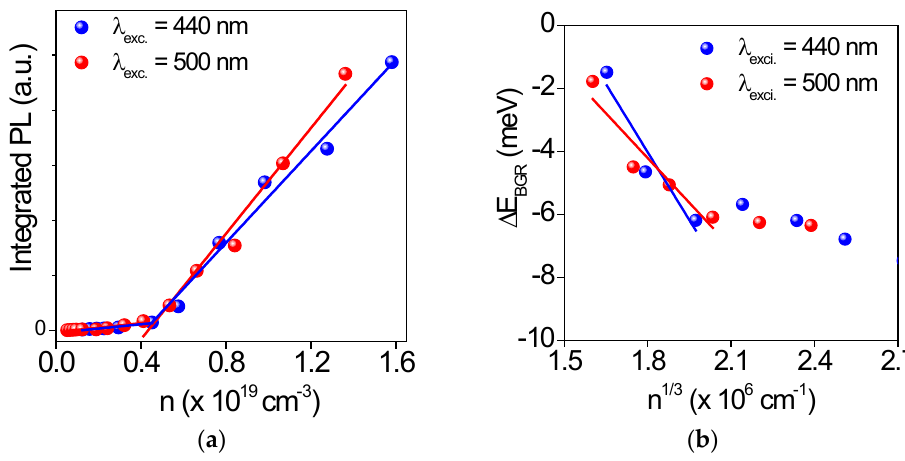
Figure 5. ( a ) Integrated PL versus the injected carrier density n, and ( b ) BGR versus n 1/3 under both 440 nm and 500 nm